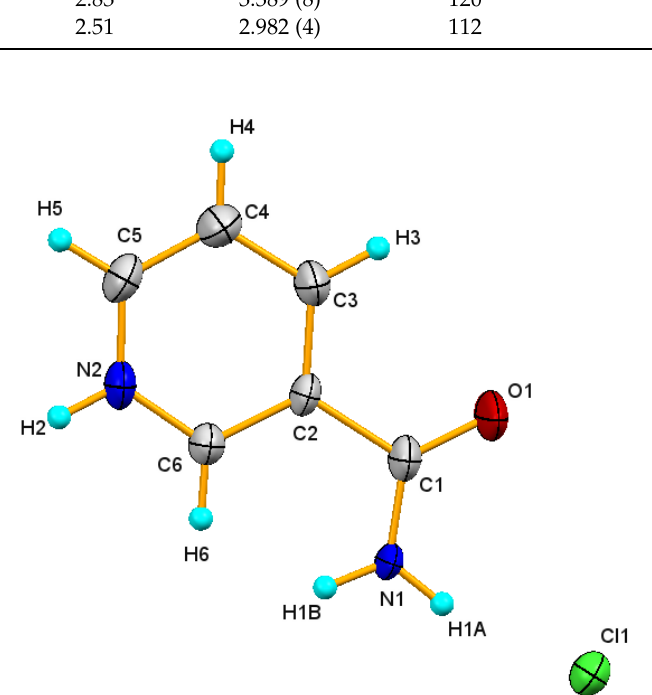
Figure 1. Molecular structure and labeling scheme (50% probability ellipsoids) of the studied salt. Crystals 2019 , 9 , x FOR PEER REVIEW